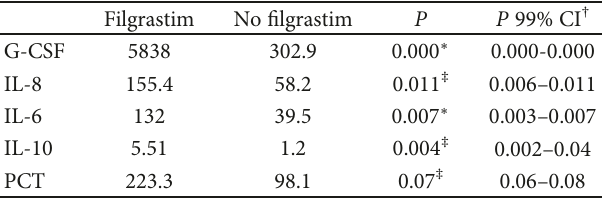
Figure 4: Temporal evolution of leukocytes along the days (in means, cells/ μ Table 5: Medians of biomarkers (pg/mL) on the day 1 of fever in patients receiving fi lgrastim or not. ∗ Mann – Whitney and median tests; ‡ Mann – Whitney test; † determined by Monte Carlo simulation with 10,000 tables.